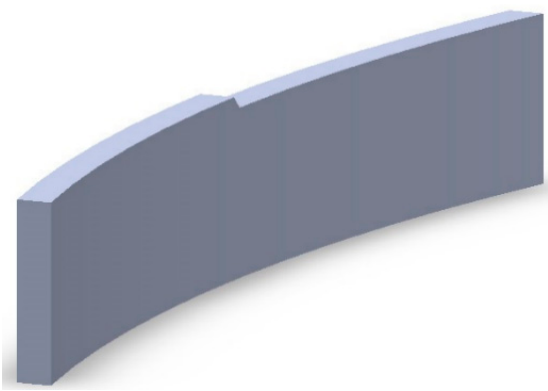
Figure 7. The baffle